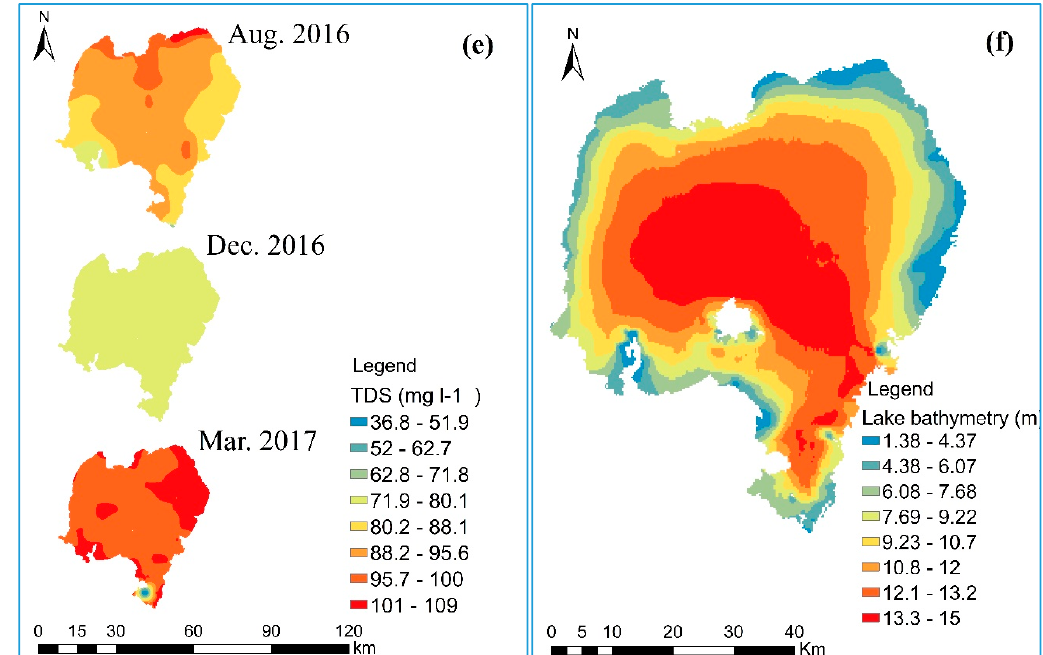
Figure 4. Spatial variability of total phosphorus ( a ), total nitrogen ( b ), temperature ( c ), pH ( d ), total dissolved solids ( e ), and lake bathymetry ( f ) over Lake Tana (August and December 2016 and March 2017, except depth data).